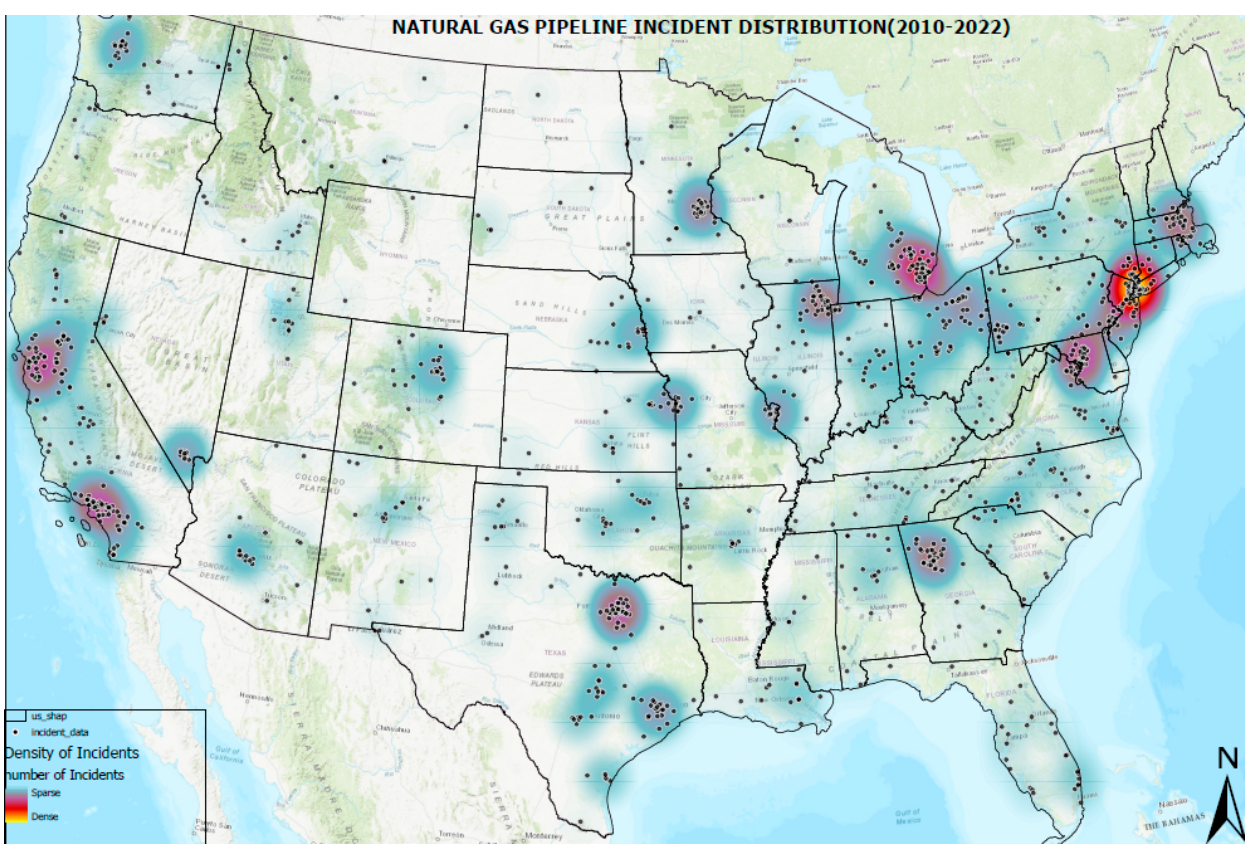
Figure 2. Distribution of natural gas incidents across the U.S. based on PHMSA 20 year incident historical data [6] .